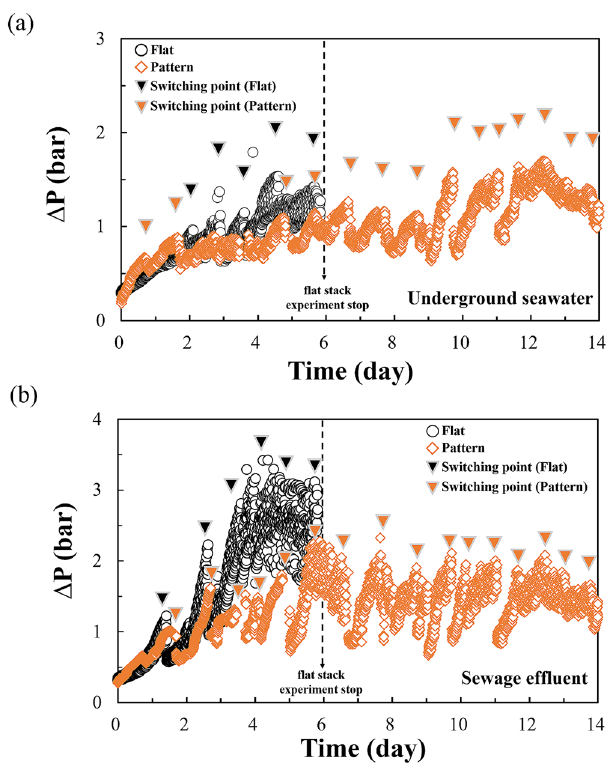
Fig. 2 Pressure drop as a function of time. a, b show pressure drop as a function of time at underground seawater side and at sewage ef fl uent side. The inverted triangles indicate switching points.